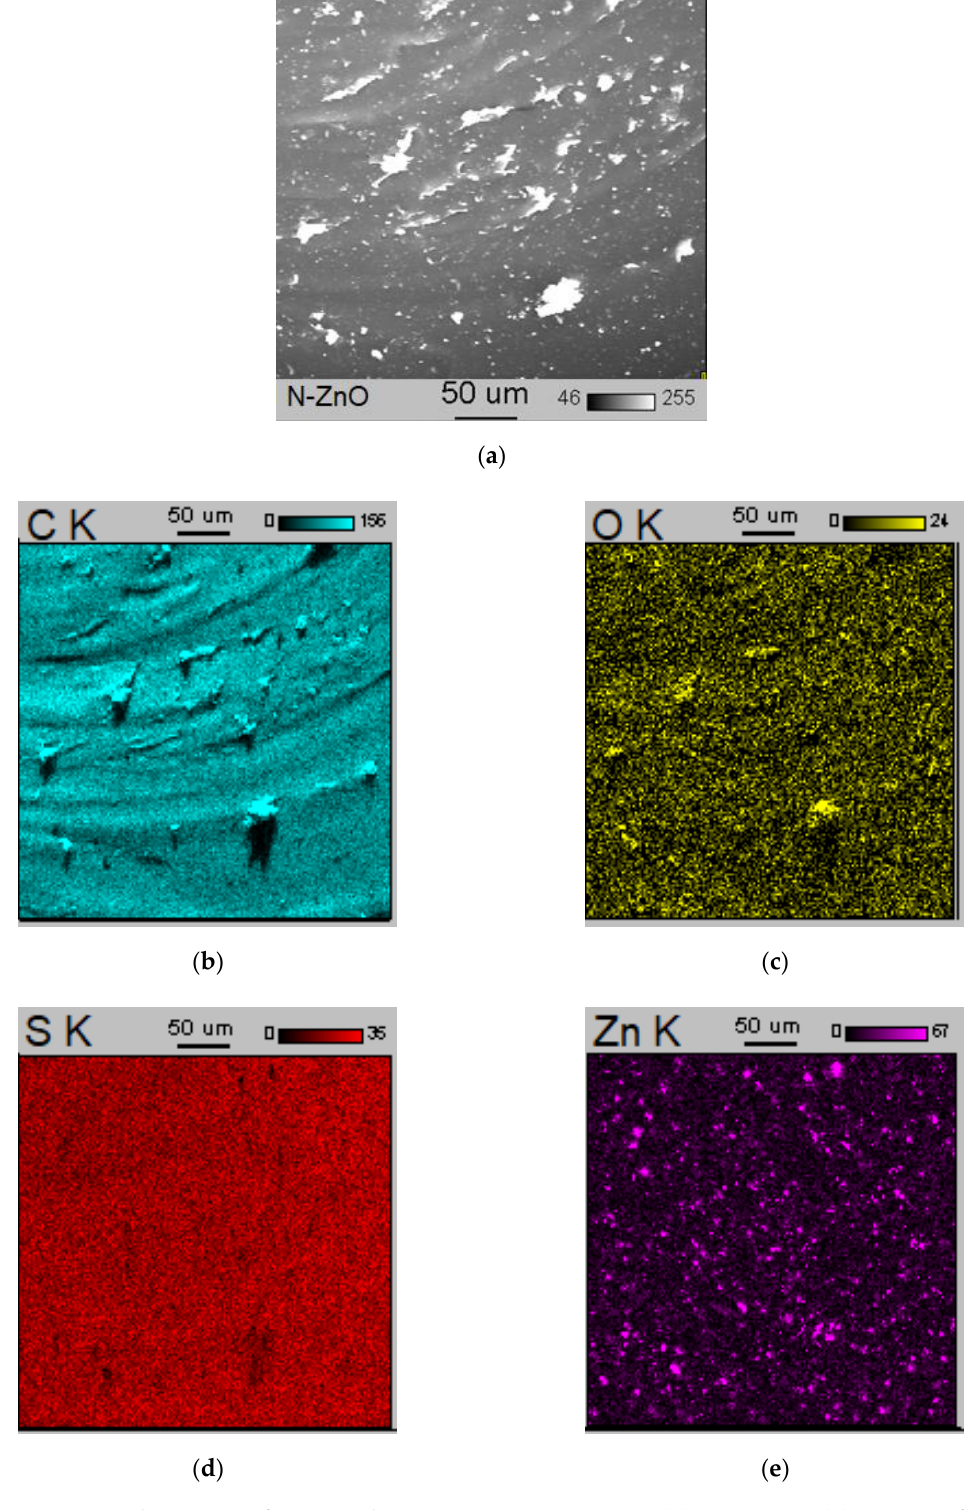
Figure 9. SEM image and EDS maps for SBR vulcanizate containing N-ZnO: ( a ) SEM image; ( b ) EDS map for C; ( c ) EDS map for O; ( d ) EDS map for S; ( e ) EDS map for Zn.